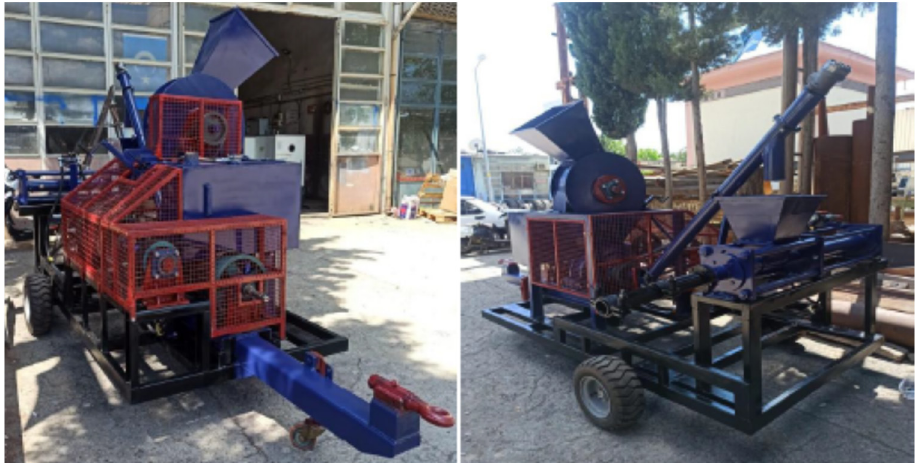
Figure 1. Prototype of mobile briquetting machine.